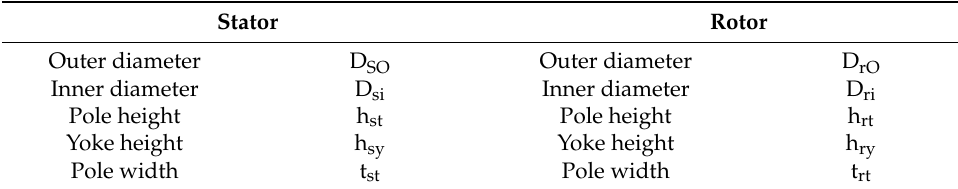
Figure 14. Structure parameters of VRM. Table 2. Main structural parameters of VRM.